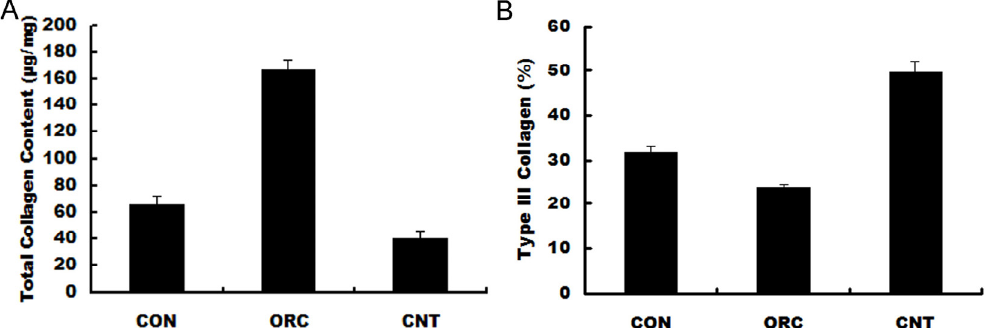
Figure 4. Results of biochemical analyses. ( A ) Total collagen content ( μ g/mg dry weight); ( B ) Type III collagen (COL3) expression relative to total of Types I and III collagen